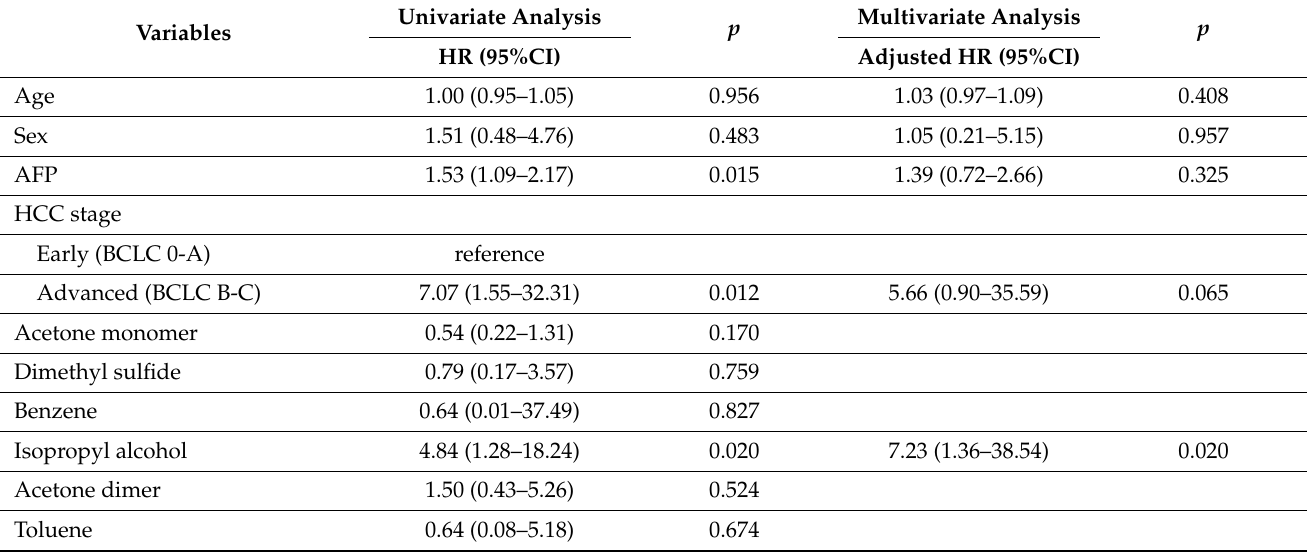
Table 4. Factors associated with survival of HCC